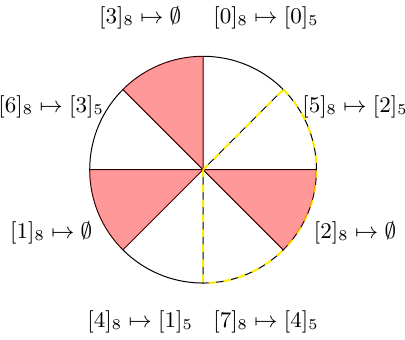
Figure 2 . Pictorial representation of action of RG 0 in the example of d = 8 , d 0 = 5 . The red segments correspond to linear matrix factorizations which are mapped to the trivial matrix factorization under RG . They are collapsed under the action. The arrows ‘ 7→ ’ indicate to which 0 linear matrix factorizations in the IR the respective UV linear matrix factorization is mapped. For instance [0] [0] means that the linear factorization with label [0] in the UV is mapped to the 8 7→ 5 8 linear factorization [0] in the IR. From this, one can read off, how any rank- 1 -matrix factorization 5 is mapped. For instance the matrix factorization with r = 3 and [ a ] = [5] corresponds to the 8 8 union of consecutive segments [5] , [2] and [7] , marked with yellow dashed boarder in the figure. 8 8 8 Under the flow, segment [2] is collapsed, and the other two obtain labels [2] and [4] . They are 8 5 5 neighboring in the IR, and their union corresponds to the matrix factorization in the IR with r = 2 and [ a ] = [2] 5 5